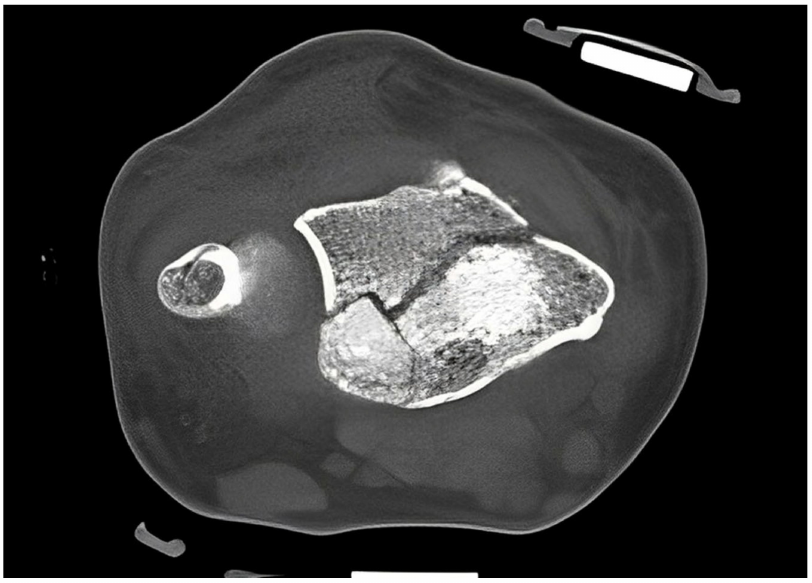
Figure 7. CT scan of a DRF in transversal view. The use of aluminum-based orthosis does not induce metal